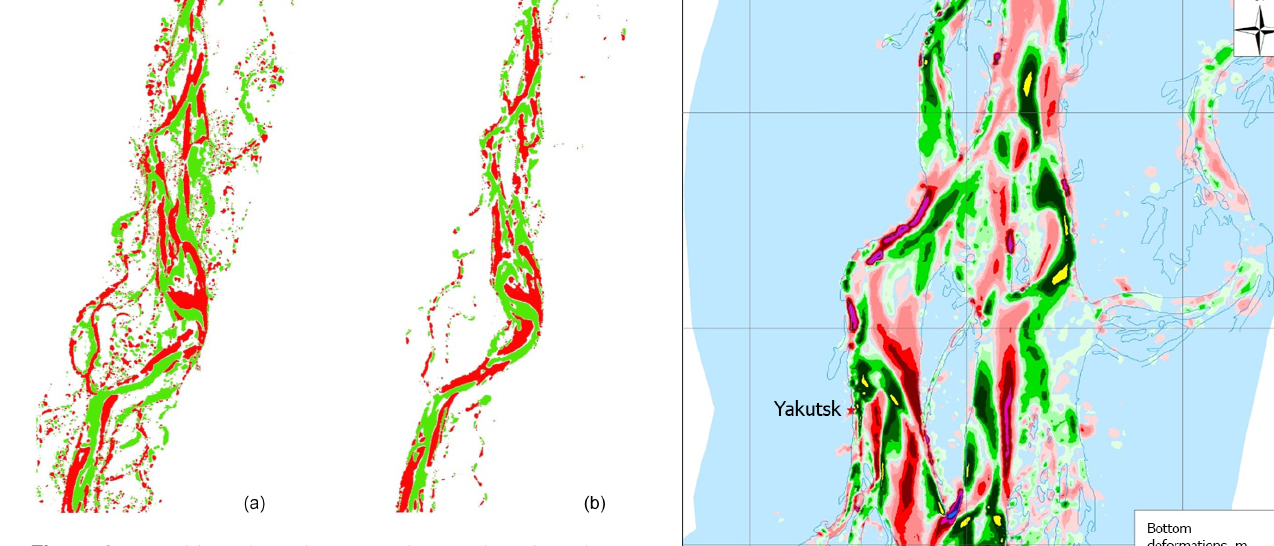
Figure 3. Deposition (shown in green colour) and erosion (shown in red colour) zones in the Lena River channel for the period 2009– 2016 year according observation data (a) and modelling (b) .